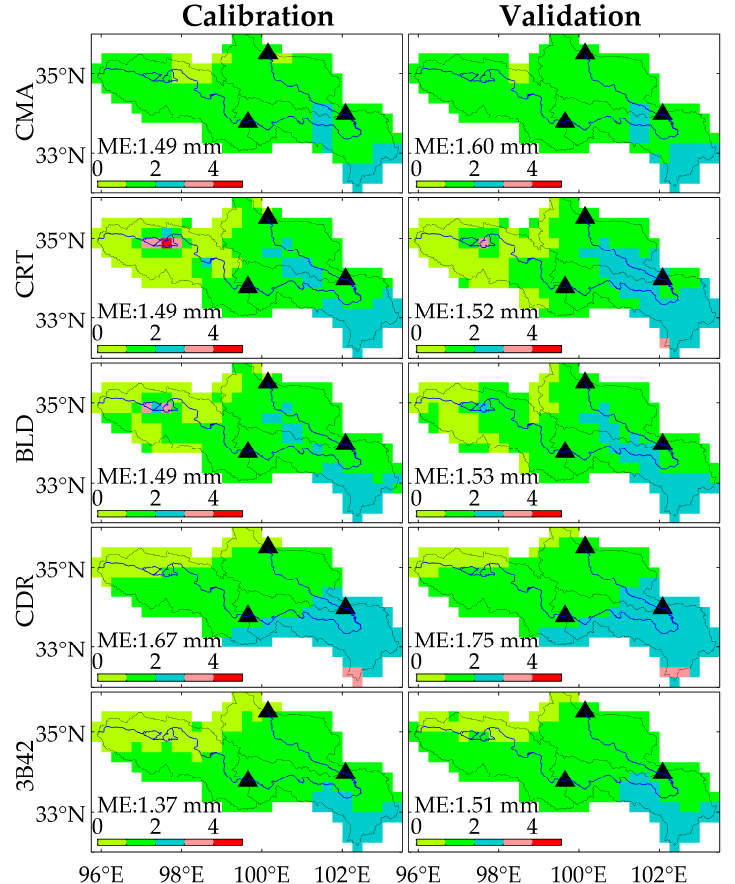
Figure 2. Spatial distribution of daily average precipitation (mm/day) derived from CMA and SGPEs during calibration (2001–2005) and validation (2006–2012) periods.